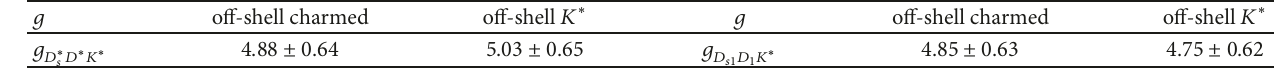
Table 4: The coupling constant of the vertices 𝐷 ∗ 푠 𝐷 ∗ 𝐾 ∗ and 𝐷 푠1 𝐷 1 𝐾 ∗ , in 𝑆𝑈 푓 (3) symmetry. 𝑔 off-shell charmed off-shell 𝐾 ∗ 𝑔 off-shell charmed